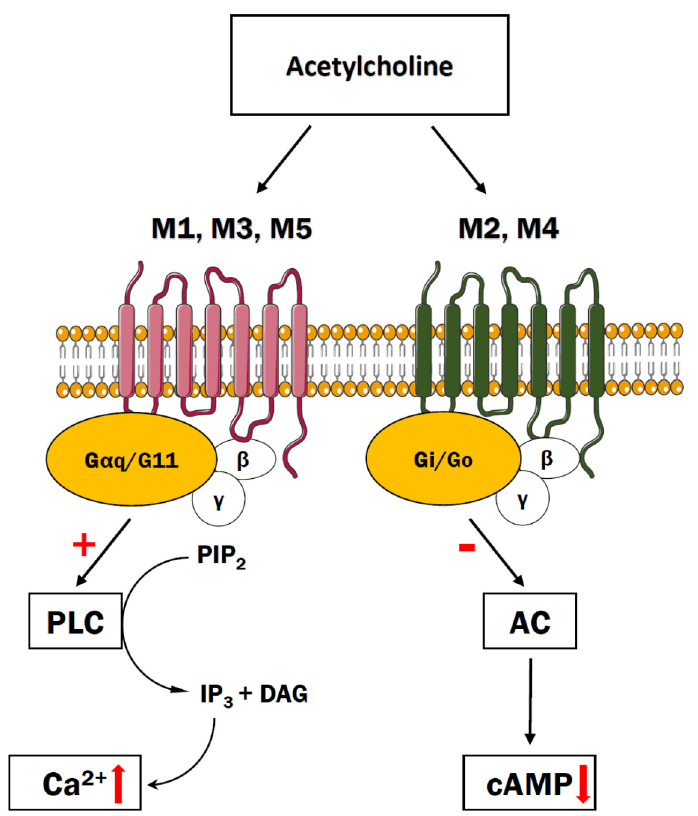
Figure 4. The cholinergic system. The ligand (acetylcholine, carbachol, pilocarpine, etc.) binds muscarinic receptors (M1, M3, M5) to stimulate Ca 2+ release from the ER via PLC-dependent signaling pathway or inhibits adenylyl cyclase when bound to M2 or M4 receptors.